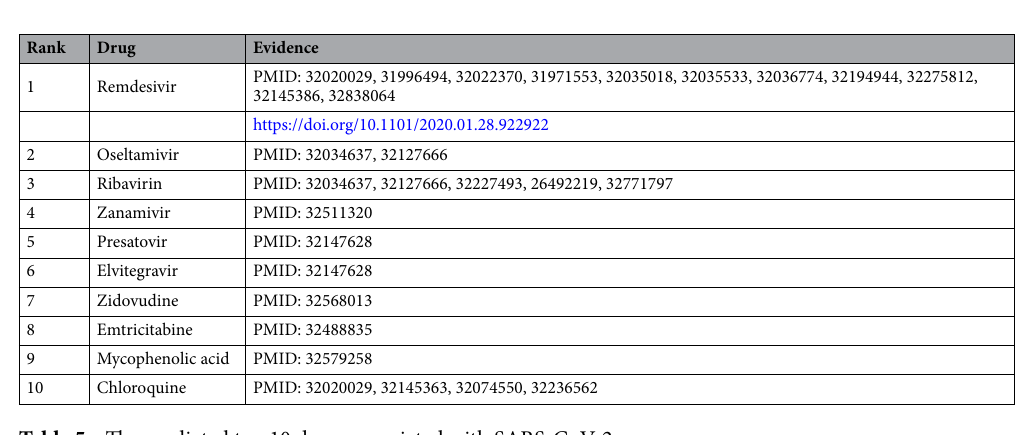
Table 5. The predicted top 10 drugs associated with